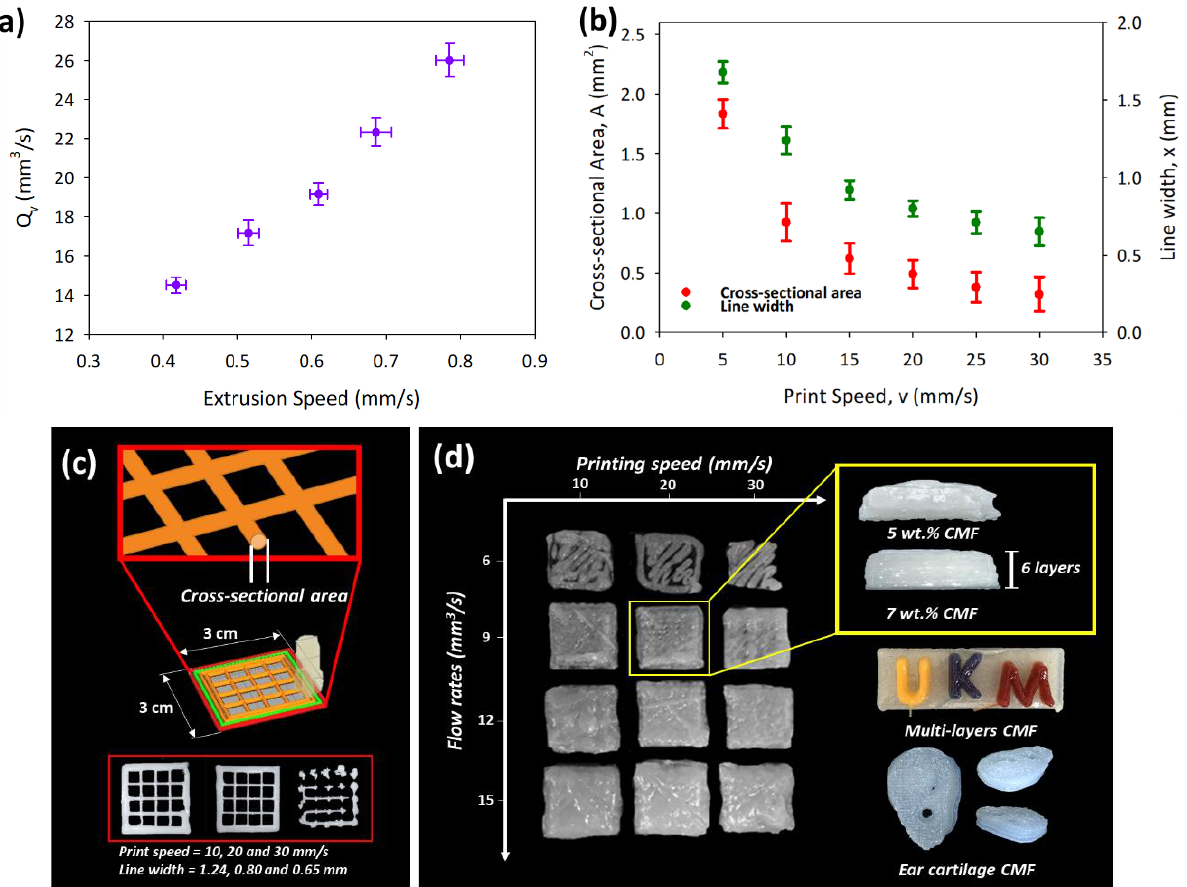
Figure 2. ( a ) CMF solution printing profiles at different extrusion speeds, ( b ) correlation of printing speed with the cross- sectional area and line width, ( c ) the finest printing profiles, and ( d ) different CMF concentrations for multiapplication CMF printing. The data are presented as mean ± standard deviation (n = 3).